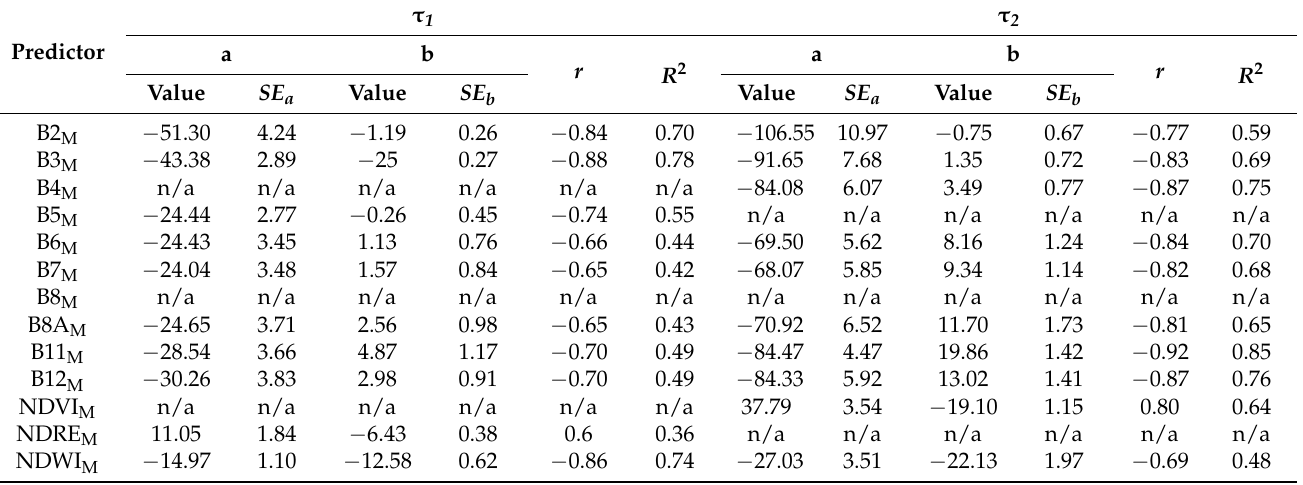
Table 6. Statistics concerning the ˆ τ 1 and ˆ τ 2 estimates by Equation (7). SE = standard error, r = Pearson correlation coefficient, R 2 = coefficient of determination. Predictors are native (“mixed”) bands and spectral indices. B8, B4, B5, NDVI and NDRE were not considered